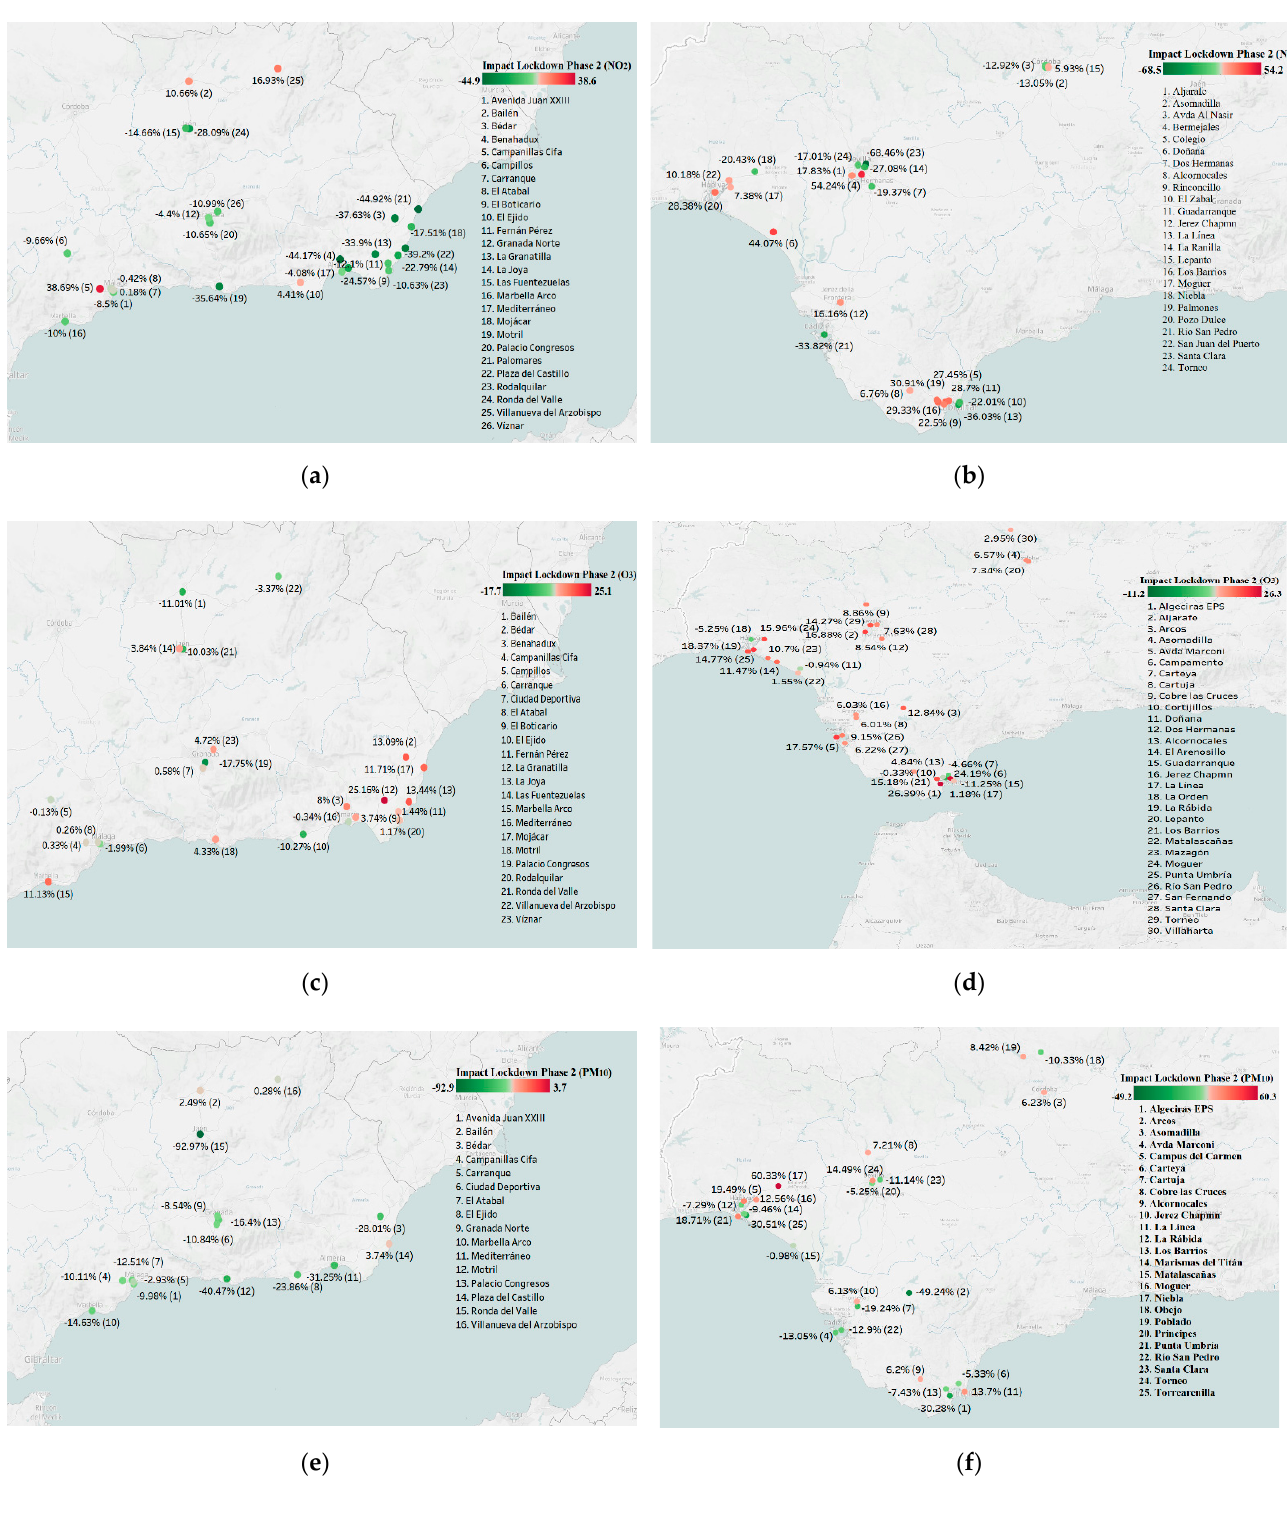
Figure 4. The left and right sides contain the estimates of the Lockdown (Phase 2) effect by air monitoring stations in the SE and SW, respectively. ( a ) Lockdown (phase 2) impact on NO 2 in SE Andalusia; ( b ) Lockdown (phase 2) impact on NO 2 in SW Andalusia; ( c ) Lockdown (phase 2) impact on O 3 in SE Andalusia; ( d ) Lockdown (phase 2) impact on O 3 in SW Andalusia; ( e ) Lockdown (phase 2) impact on PM 10 in SE Andalusia; ( f ) Lockdown (phase 2) impact on PM 10 in SW Andalusia. By taking the variable Saharan dust as a reference, we can contextualize the scope of pollution reduction caused by traffic restrictions during the COVID-19 lockdown when